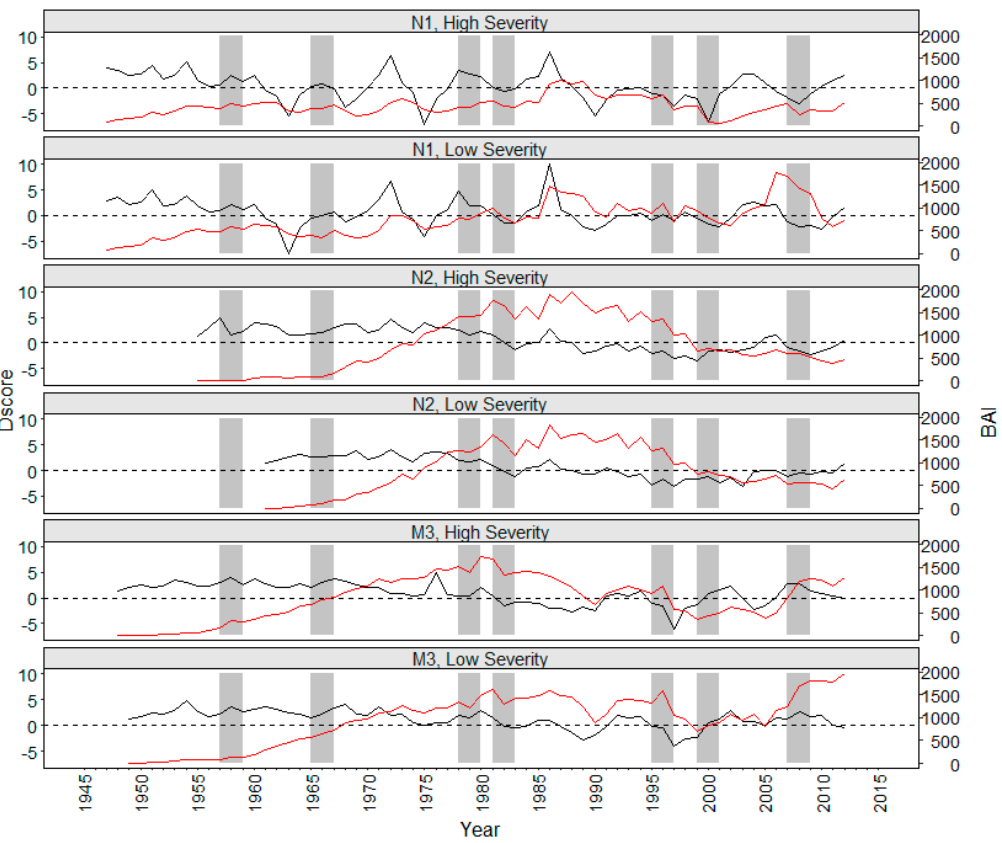
Figure A1. Decline scores (D scores ) associated with Basal Area Increment (BAI) values, separated by site and Caliciopsis symptom severity class. Black solid lines represent annual D scores (averaged per severity class and site). Black horizontal dashed lines represent the decline cutoff; D scores < 0 are declining stands. Red solid lines represent BAI values (averaged per severity class and site). Gray